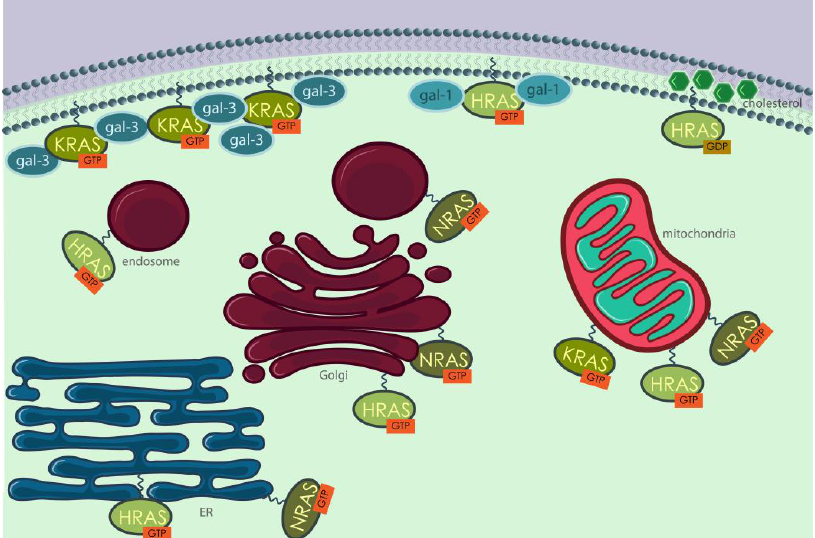
Figure 6. Human RAS proteins are localized in different cellular compartments, almost always associated with membranes. KRAS and HRAS are found in the inner leaflet of the plasma membrane, associated with galectin-3 [151,152] and galectin-1 [153], respectively. Inactive HRAS is very often located in cholesterol-rich structures called caveolae. RAS proteins can also signal from the membranes of internal organelles, such as ER, Golgi, mitochondria and the endosomal system. Yeast RAS proteins also localize in different cell compartments in order to activate different effectors and thereby to control different processes [154]. Indeed, fluorescent tagging of yeast RAS proteins and their partners, including the GAP Ira proteins and the GEF Cdc25, showed that most of these molecules are actually localized on endomembranes [154]. In particular, Ras2 activates adenylyl